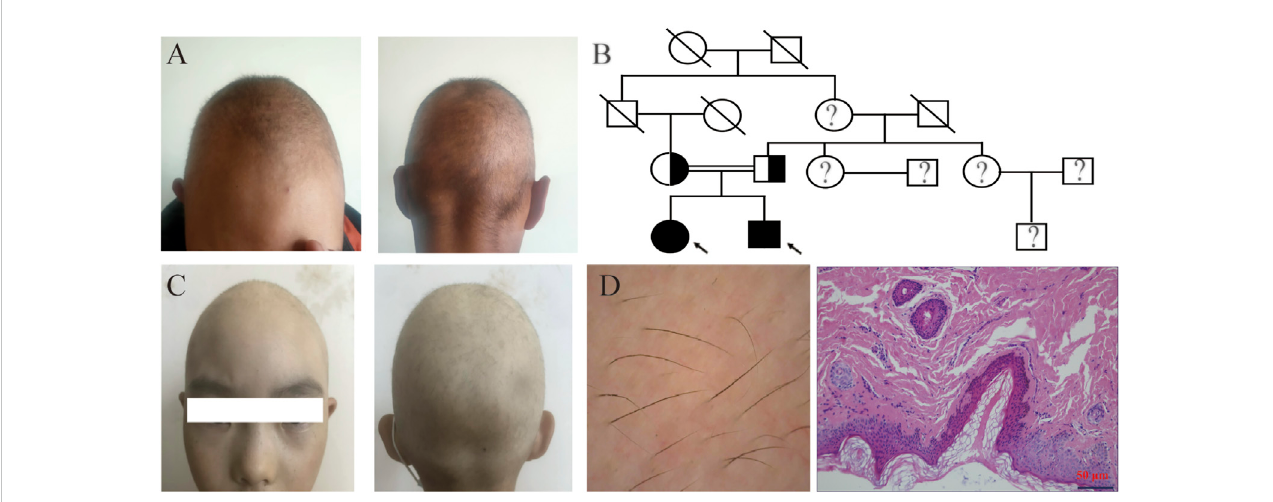
FIGURE 1 Clinical features of the patients. (A) Clinical pictures of the proband showing sparse and thin scalp hair and normal eyebrows. (B) Pedigree analysis of the familyaffectedbythe LSS mutation.Thearrowpointstotheproband;blackandwhiterepresentmutantandwildtype;circlesandsquaresdenotefemalesand males; soliduses represent deceased family members; and question marks denote family members not included in this study. (C) Clinical pictures of the proband ’ s sister. (D) Skin examination through dermoscopy (left) and skin biopsy (200×) (right).